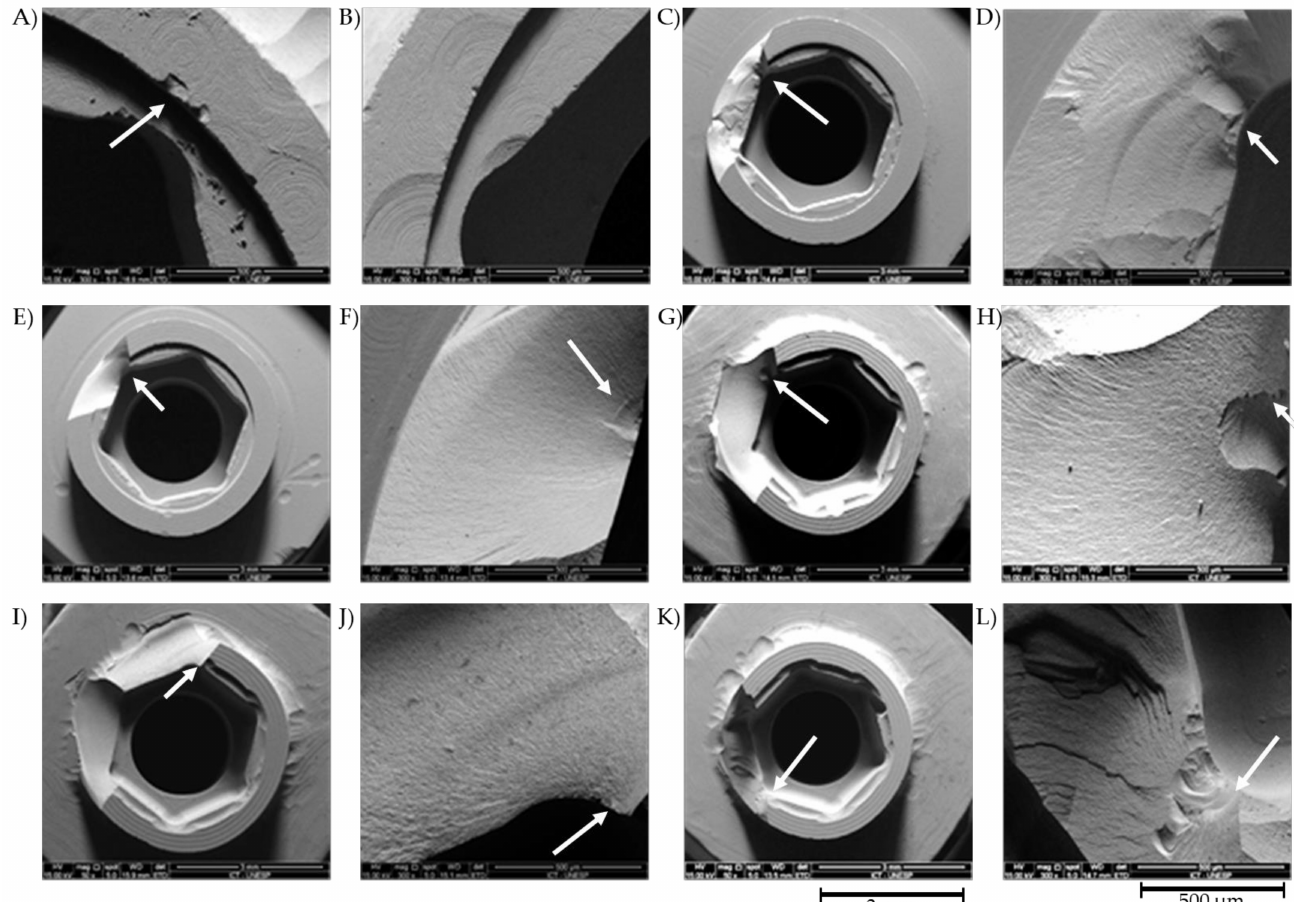
Figure 3. Small defects from milling are seen in the internal parts of the representative crowns ( A – L ). The fractured crowns are seen on the left and the circles are the depicted images on the right. The defects close to the hexagons (solid arrows) and fracture marks were mainly hackles and arrest lines.